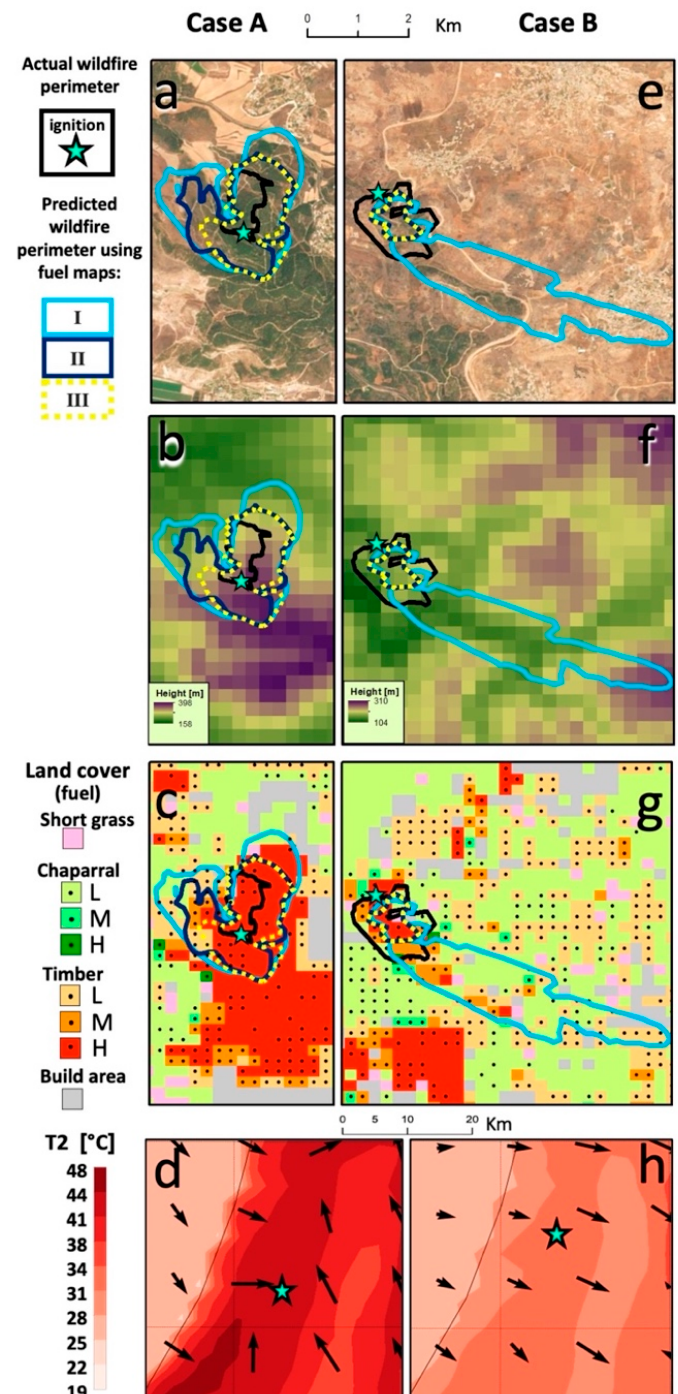
Figure 4. The two case studies: ( a – d ) Bet Shemesh (case A in Figure 2), and ( e – h ) Modiin (case B in Figure 2). ( a , e ) Maps of the actual (black line) and predicted wildfire perimeters (light blue, dark blue, and yellow lines, for fuel maps I, II, and III in Table 2); ( b , f ) topography at the two case studies; ( c , g ) land-cover fuel maps: the dots in the pixels represent the negative trend of woody vegetation, the letters represent low (L), medium (M), and high (H) levels of AGB for chaparral (L = 120, m = 154, H = 180 t ha − 1 ) and timber (L = 110, M = 120, G = 130 t ha − 1 ); ( d , h ) 2 m air temperature and wind vectors in the zone of the wildfire at 12:00 using the WRF forecasting model. The star represents the location of ignition. (Additional details of the WRF-Fire results from the three fuel map simulations for three observed times are shown in Figure A1 in Appendix